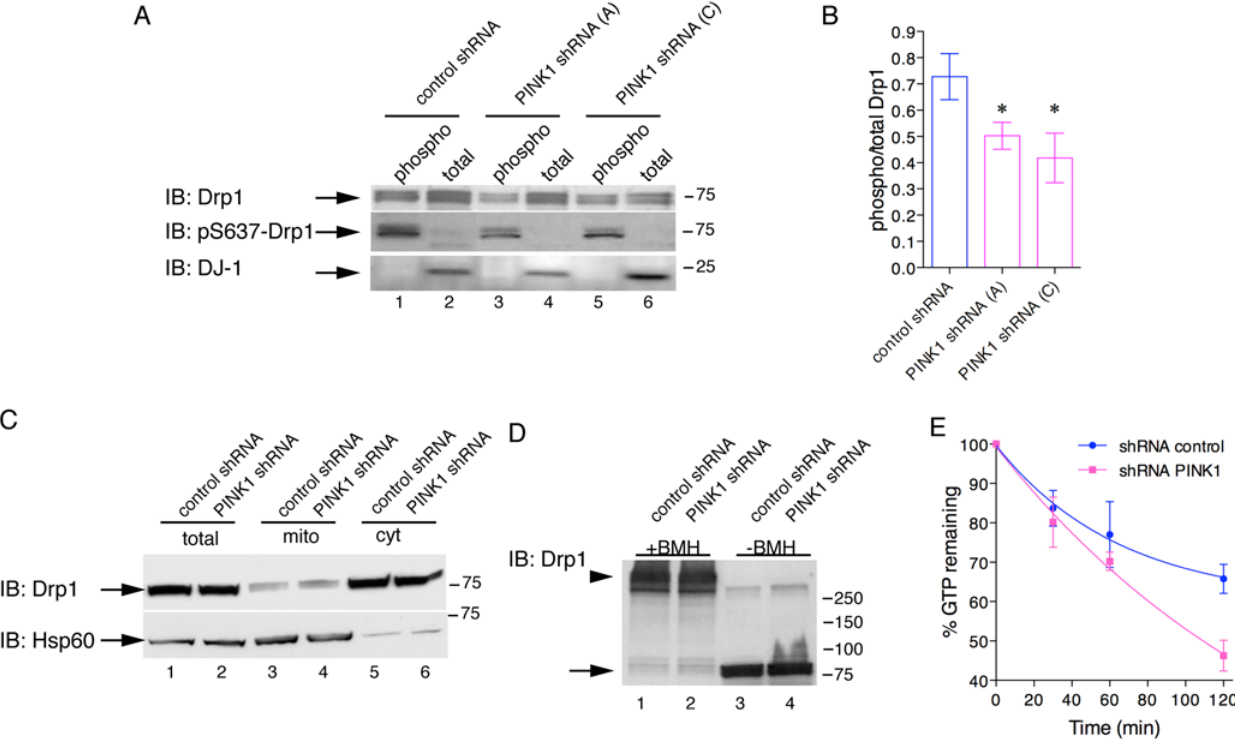
Figure 7. Dephosphorylation and increased GTPase activity of Drp1 in PINK1 deficient cells. (A) Lysates from control shRNA lines or either of two PINK1 shRNA lines were separated by phospho-enrichment compared to total lysates and blotted for the proteins indicated on the left of the blots. Drp1 was in both phospho-enriched and total fractions, but less phospho-Drp1 was seen in the PINK1 deficient cells. We used phospho- Drp1 to confirm the phosphopurification was efficient and DJ-1 served as a negative control. (B) Quantification of Drp1 as a ratio of the phospho- enriched and total fractions shows that there was an , 30% decrease in phospho-Drp1 ( n =3) that is consistent between both shRNA sequences (*, P , 0.05 by ANOVA). (C) Recruitment of endogenous Drp1 to mitochondrial fractions (mito) is similar in control and PINK1 shRNA cell lines (total: whole cell lysates, cyt: cytosolic fractions). Data are representative of duplicate experiments and molecular weight markers on the right of the blots are in kilodaltons. (D) Oligomerization status of Drp1 is not affected by PINK1 shRNA compared to control lines. Lysates were crosslinked with BMH or not treated to show equivalent loading of Drp1. Arrowhead shows Drp1 oligomers, arrow shows monomeric Drp1. Molecular weight markers are in kilodaltons. (E) GTPase activity of Drp1 immunopurified from control or PINK1 shRNA cell lines was followed over time and expressed as percentage of GTP converted to GDP. The difference between the lines was significant ( P , 0.01 by two-way ANOVA). Each point is the average of 3 replicates and is representative of two independent